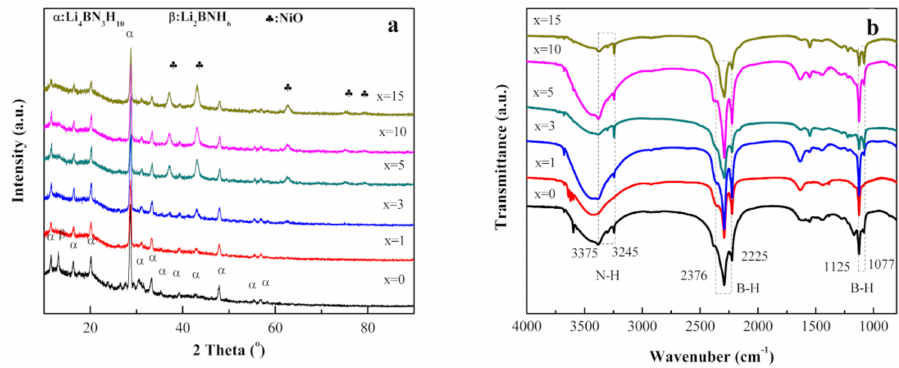
Figure 3. XRD patterns ( a ) and FTIR spectra ( b ) of the LiBH 4 -2LiNH 2 - x wt. %